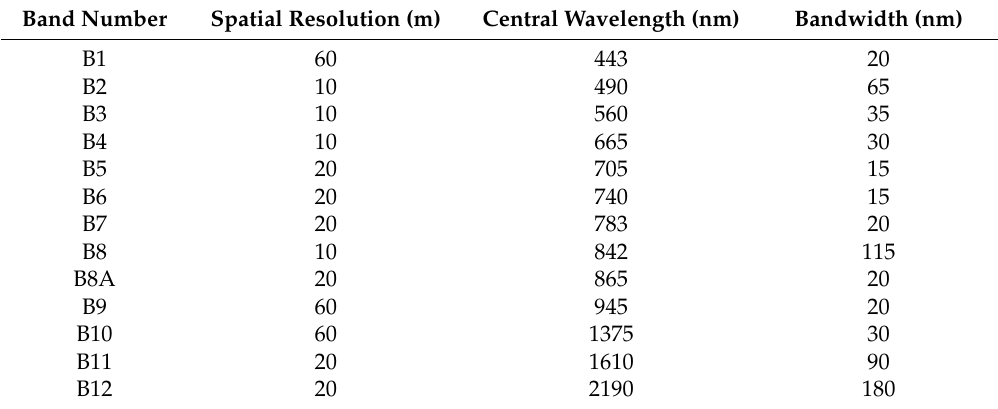
Table 1. Band spatial resolution, central wavelength and bandwidth of the Sentinel-2